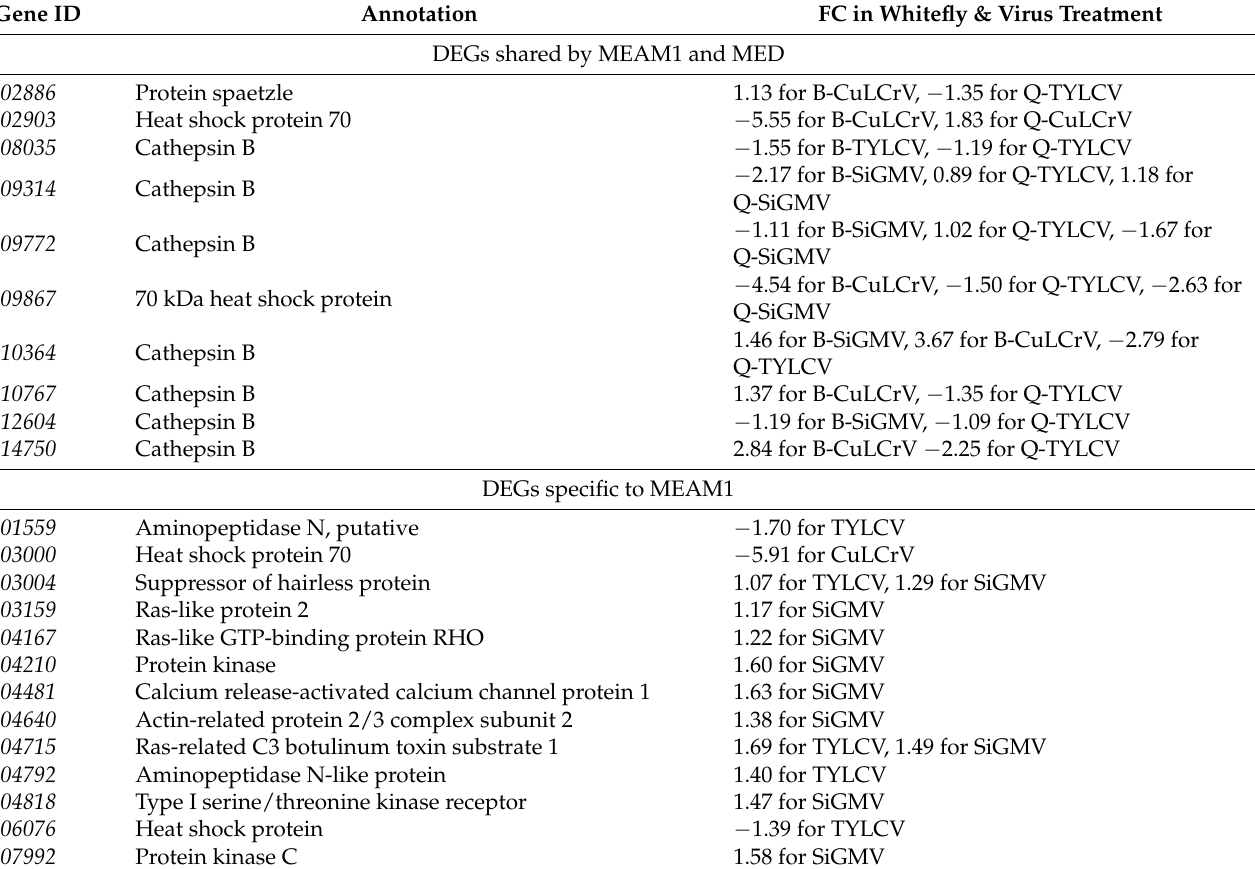
Table 4. Differential expression of genes associated with immune system categories in viruliferous compared with non-viruliferous Bemisia tabaci Middle East-Asia Minor 1 (MEAM1) and Mediter- ranean (MED)